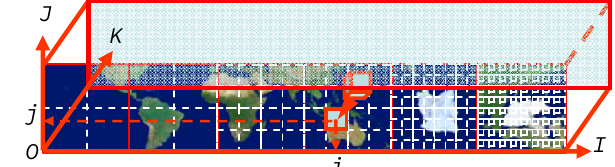
Figure 12. ROS near equator